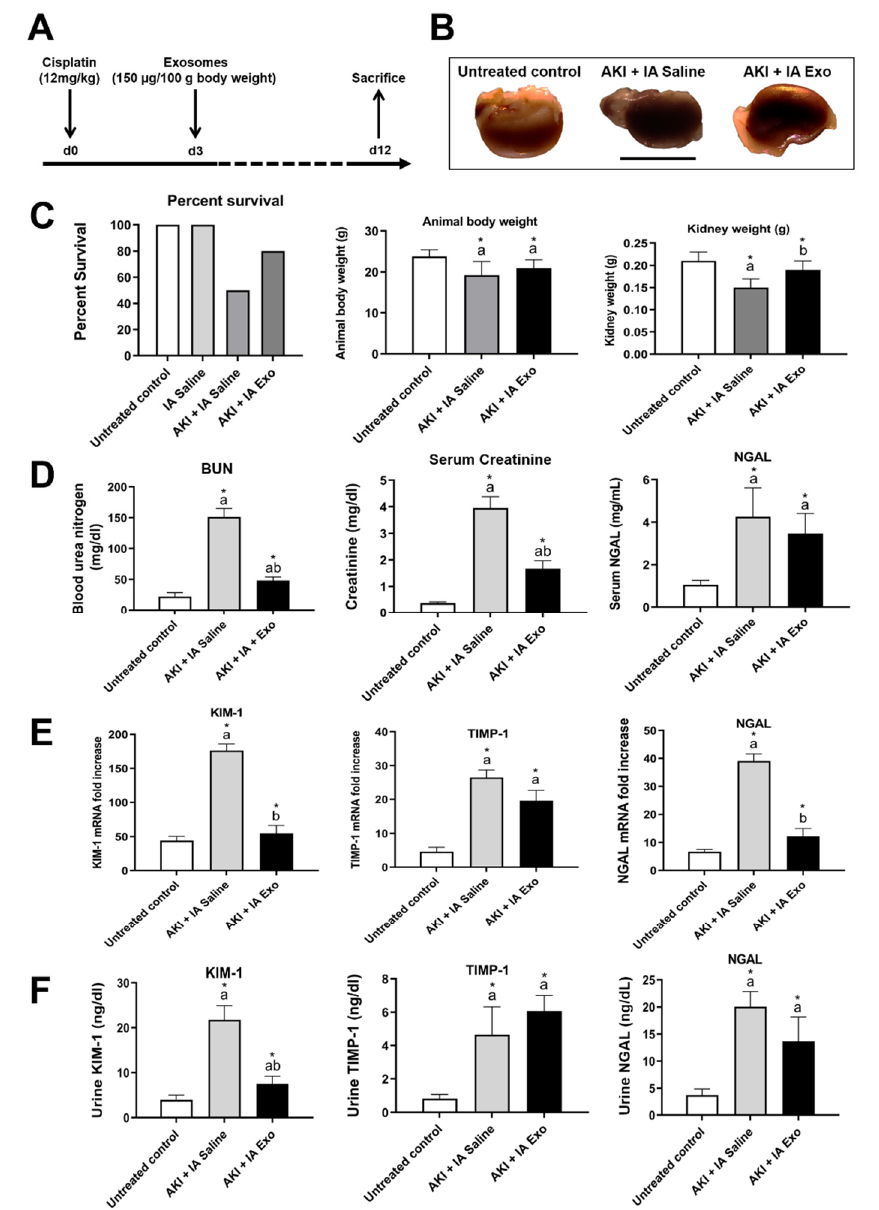
Figure 2. Physiological and molecular markers of kidney injury. ( A ) Study protocol. ( B ) Gross appearance of kidney. ( C ) Percent survival, animal body weight, and kidney weight. ( D ) Serum concentration of blood urea nitrogen (BUN), creatinine, and NGAL, as measured by serum ELISA. ( E ) mRNA expression of KIM-1, TIMP-1, and NGAL in kidney lysates, as measured by qRT-PCR. ( F ) Urine concentrations of KIM-1, TIMP-1, and NGAL, as measured by urine ELISA. Measurements were taken at day 12. Each group has n = 8 mice, except for survival data for which n = 10 for untreated controls and n = 20 mice for other groups. Significant difference a p < 0.05: relative to untreated control group; b p < 0.05: relative to AKI + IA saline group.